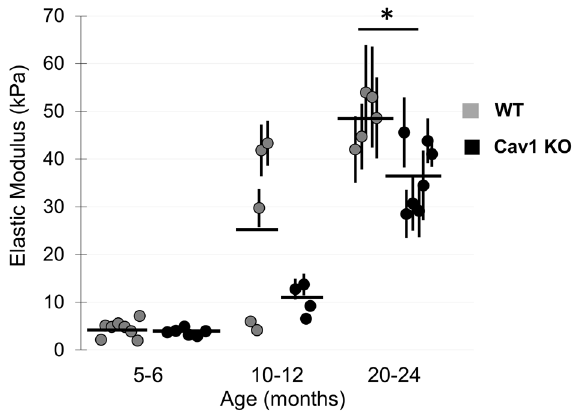
Figure 8. Age-associated increase in mouse aortic sub-endothelial layer stiffening is mitigated by Cav-1 deletion. Summary of sub-endothelial aortic elastic modulus recordings (average of DA and Arch) from WT and Cav-1 KO mice at three age groups. *P < 0.05 using